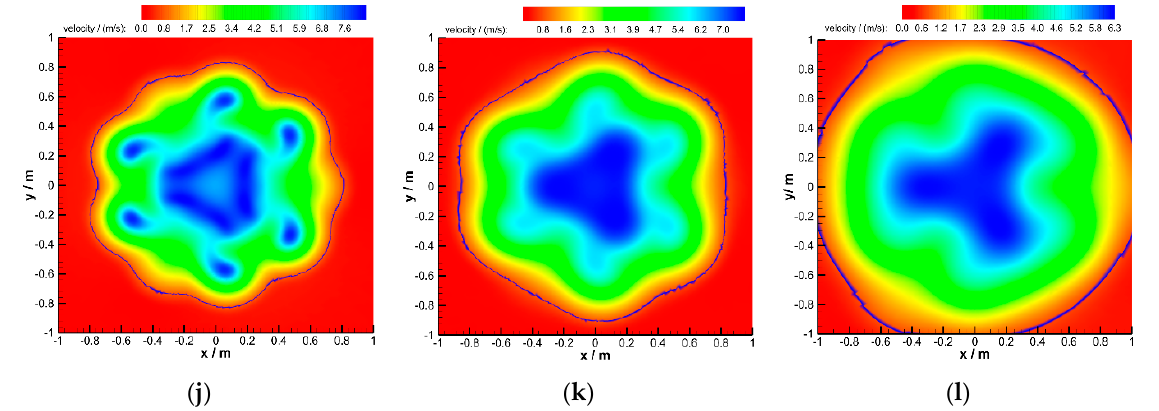
Figure 7. Velocity distribution of the XOY cross-sections for downwash airflow under different loads: ( a ) Load of 0 kg at z = 0.926 m plane; ( b ) Load of 0 kg at z = 1.426 m plane; ( c ) Load of 0 kg at z = 1.926 m plane; ( d ) Load of 0 kg at z = 2.426 m plane; ( e ) Load of 0 kg at z = 2.926 m plane; ( f ) Load of 0 kg at z = 3.426 m plane; ( g ) Load of 4 kg at z = 0.926 m plane; ( h ) Load of 4 kg at z = 1.426 m plane; ( i ) Load of 4 kg at z = 1.926 m plane; ( j ) Load of 4 kg at z = 2.426 m plane; ( k ) Load of 4 kg at z = 2.926 m plane; ( l ) Load of 4 kg at z = 3.426 m